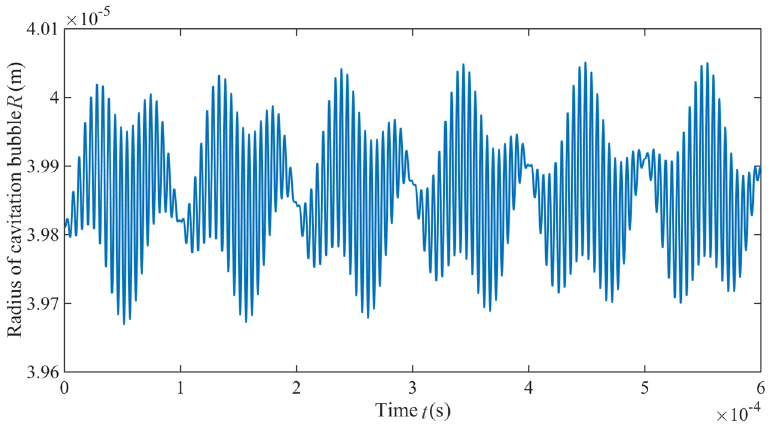
Figure 5. Overall trend of the single cavity radius in the grinding